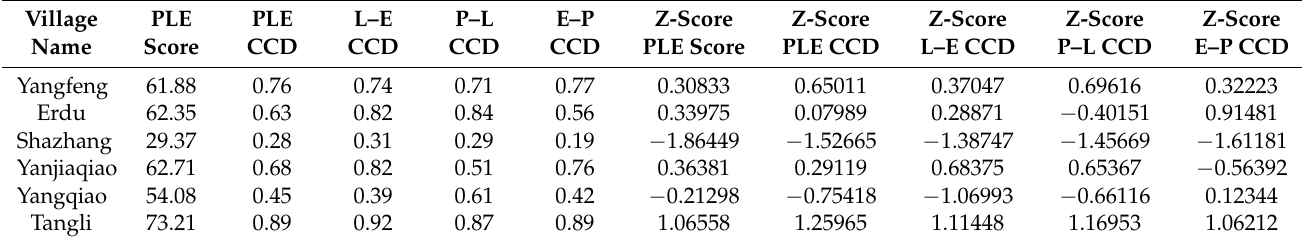
Table 5. The score of PLE, coupling coordination degree scores and Z-score processing